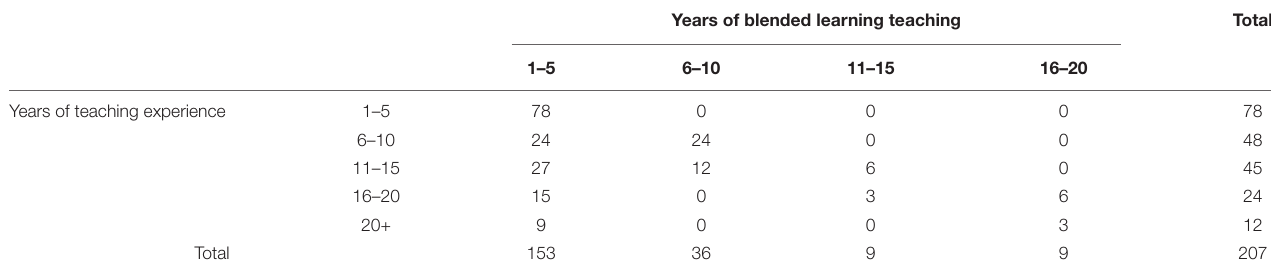
TABLE 4 | Years of teaching experience × years of blended learning teaching cross